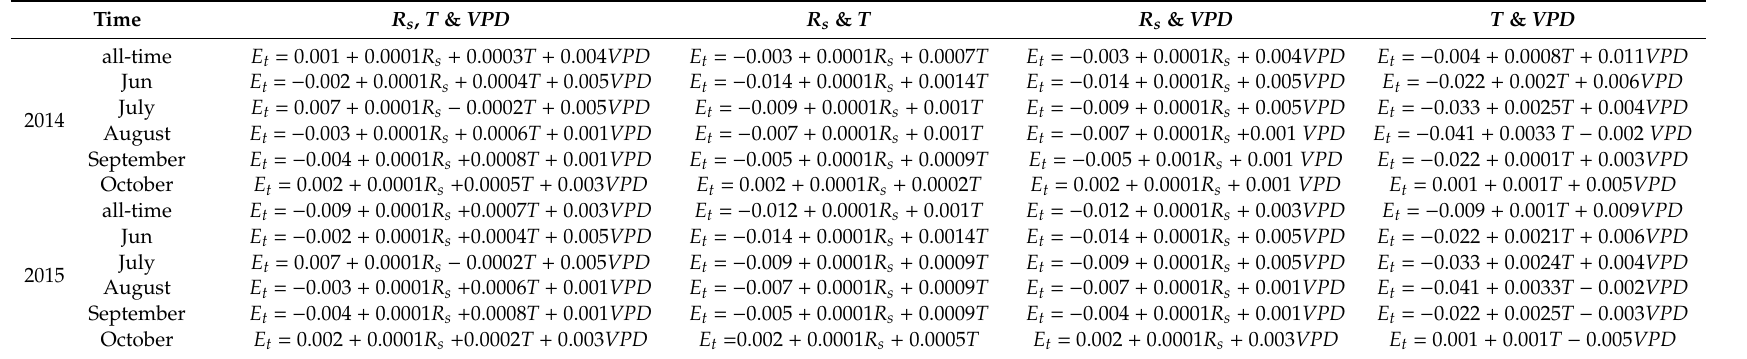
Table A1. Multivariate linear equation between stand transpiration ( E t ) and solar radiation ( R s ), air temperature ( T ), and vapor pressure deficit ( VPD